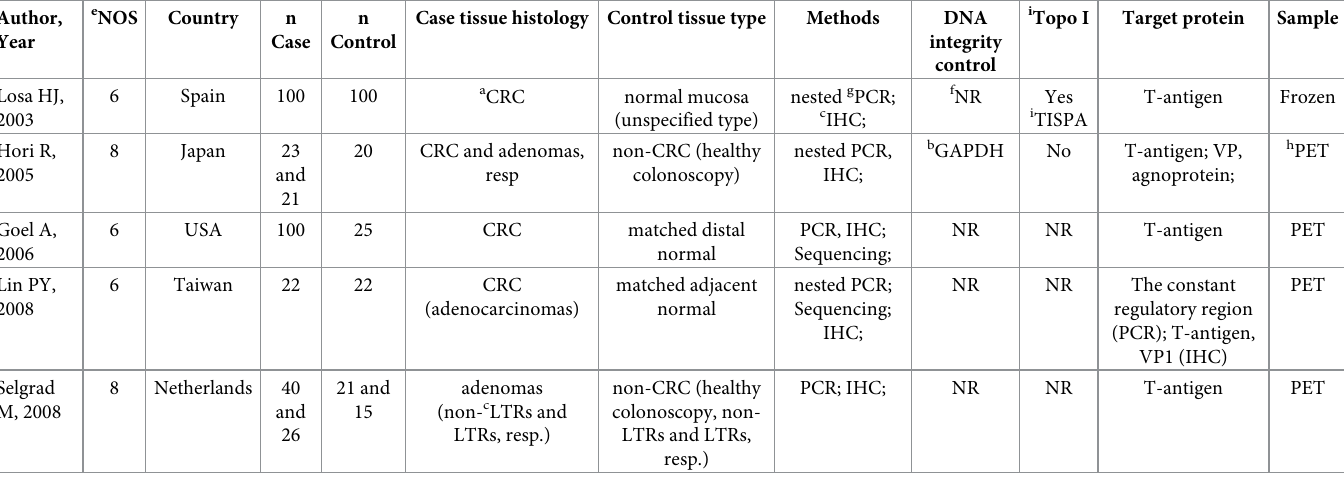
Table 1. Summary of basic characteristics of the 5 case-control studies included in meta-analysis for JCV T-antigen protein expression by IHC in CRC or adenoma.